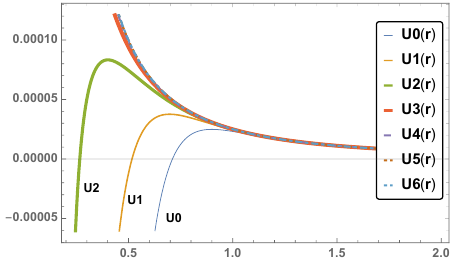
Figure 2 . The potential U p ( r ) with T p =1 and L = 0 : 01.